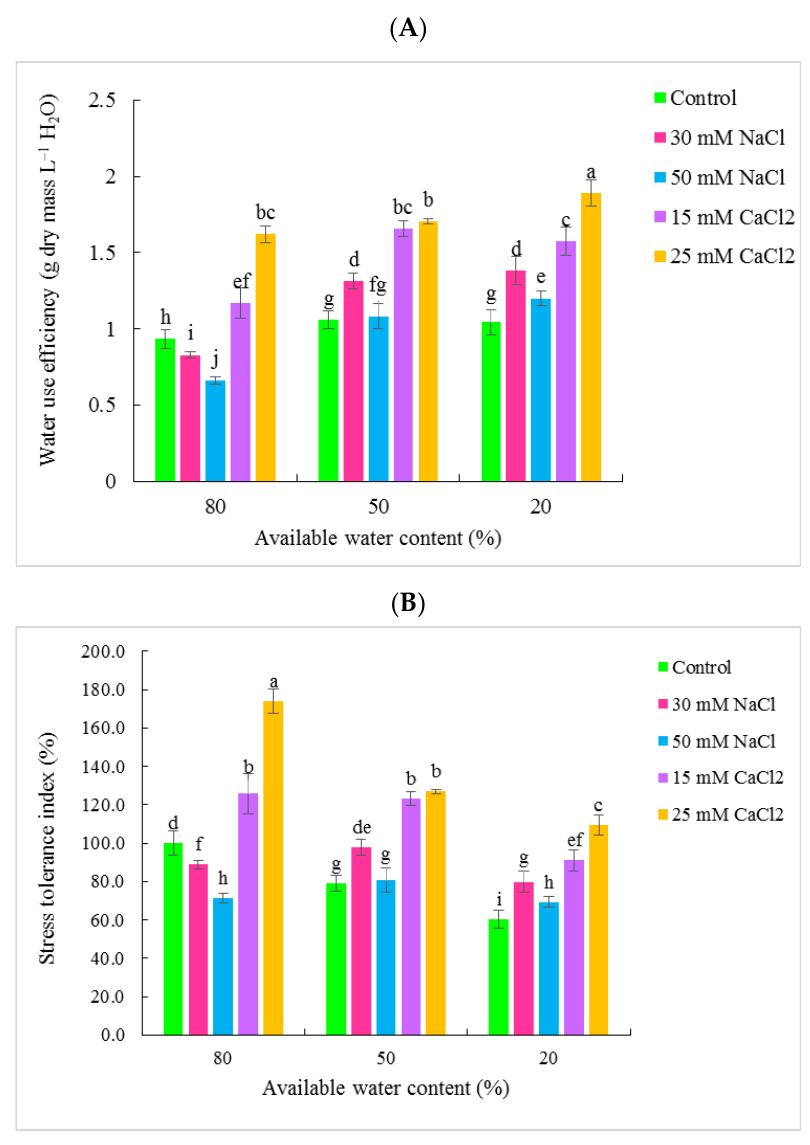
Figure 3. Water use efficiency ( A ) and stress tolerance index ( B ) of periwinkle cv. ‘Pacifica XP Really Red’ plants initially receiving NaCl (0, 30 and 50 mM) or CaCl 2 (15 and 25 mM) via irrigation (five applications at 3 d intervals), and subsequently exposed to different watering levels (80, 50 and 20% available water content) during cultivation. At first application, plants were at the four-leaf stage. Values with different letters indicate significant differences ( P = 0.05; comparison in columns). Values are the mean of four replications.